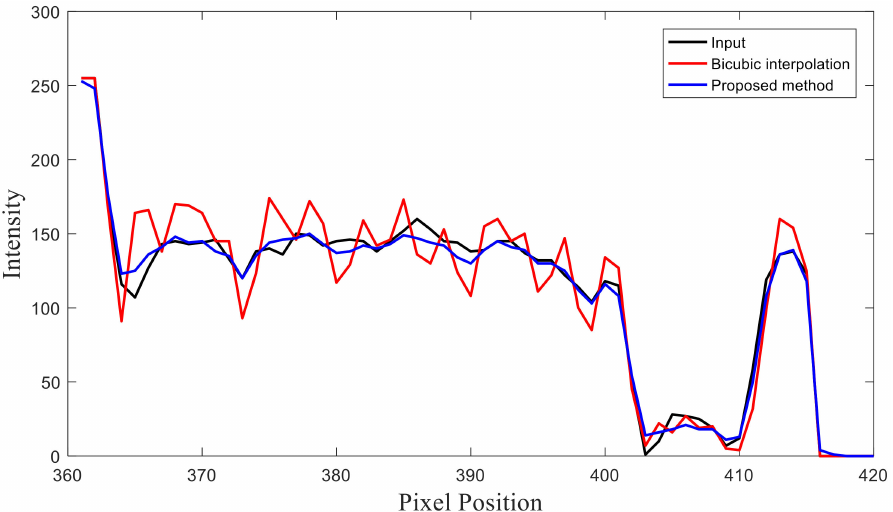
Figure 3. Profiles of different results are shown for the 320th row of the image in Figure 2. The black curve represents the profile of the original CT image in Figure 2a. The red curve represents the profile of the reconstructed CT image obtained using the bicubic interpolation method in Figure 2c. The blue curve represents the profile of the reconstructed CT image obtained using the proposed method in Figure 2d.